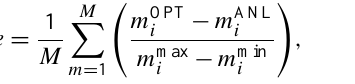
tion trials by the µGA. See text for